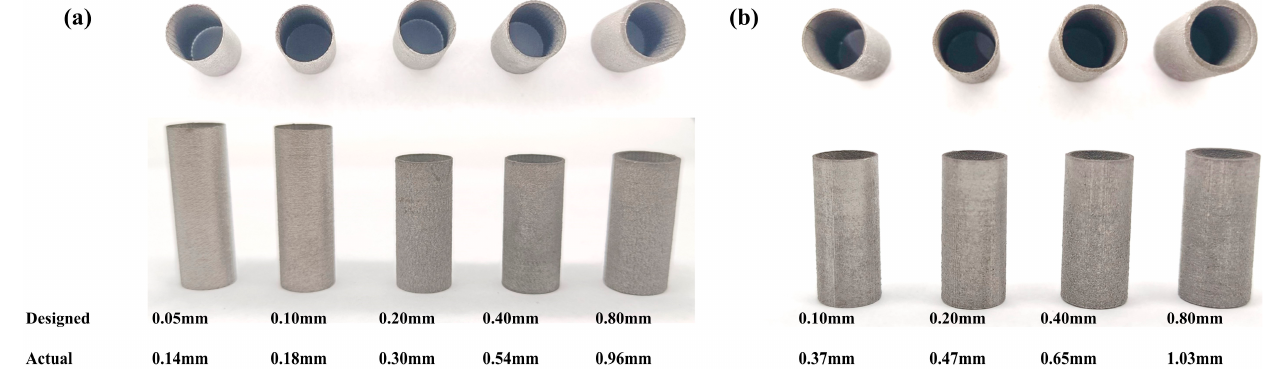
Figure 7. FeCrAl cladding of different thickness in LPBF, ( a ) ring scanning and ( b ) bidirectional scanning.